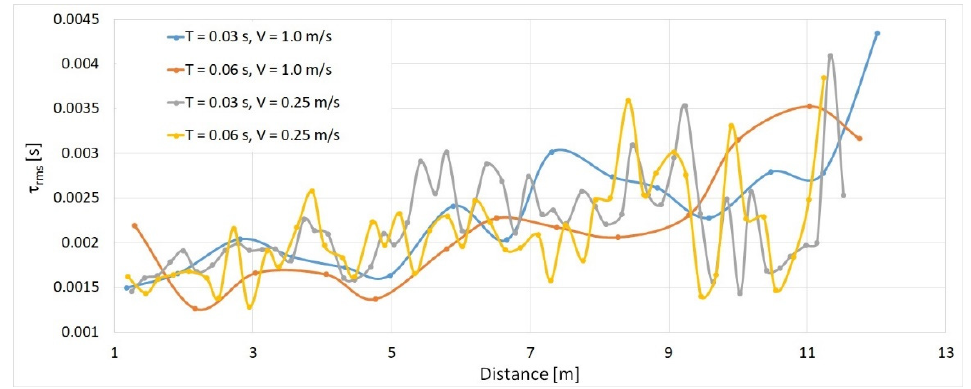
Figure 13. Influence of the distance from the receiver on the delay spread for chirps with a center frequency of 𝐹 (cid:3004) = 60 kHz , a duration of 𝑇 = 30 ms , and different bandwidths, 𝐵 , for transmitter velocities of 𝑉 = 1 m/s and 𝑉 = 0.25 m/s .